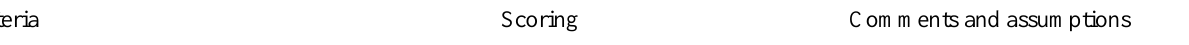
Table 1. Scoring system for evaluating bird species sensitivity to